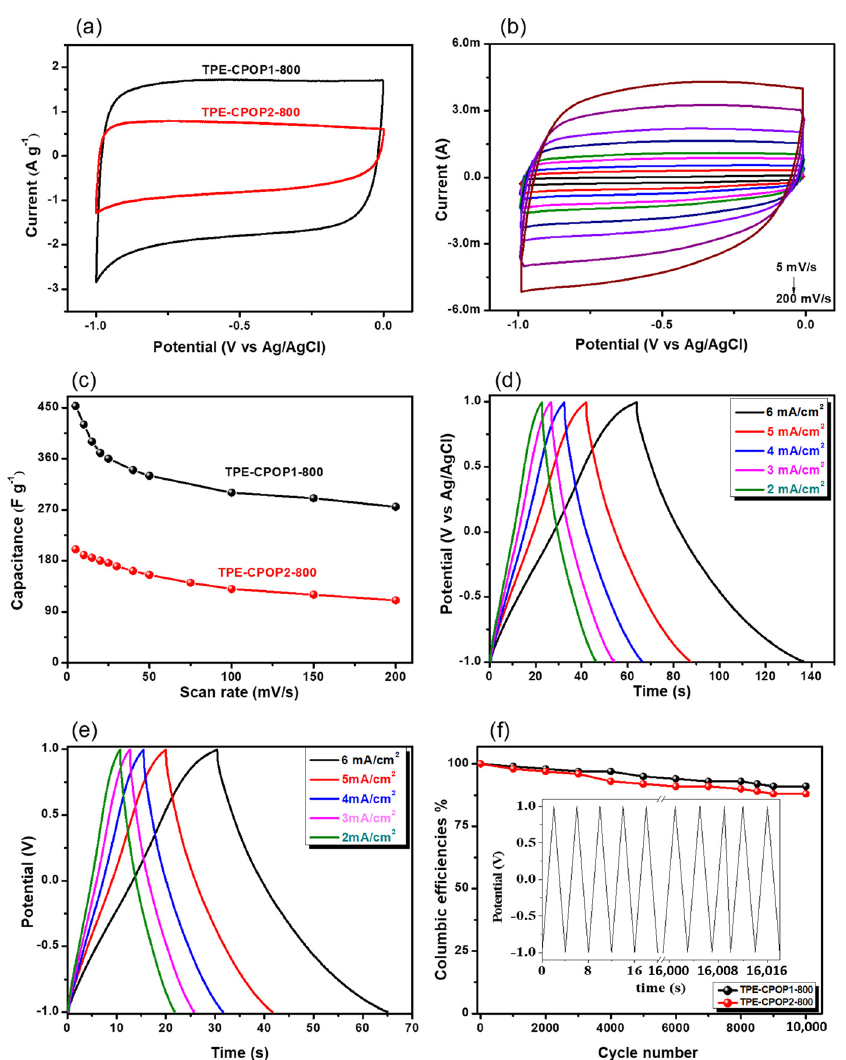
Figure 11. ( a ) Comparison of CV performance between TPE-CPOP1-800 and TPE-CPOP2-800 at 50 mV/s. ( b ) CV performance of TPE-CPOP1-800 at various scan rates (5~200 mV s − 1 ). ( c ) Capacitance performance of TPE-CPOP1-800 and TPE-CPOP2-800 at various scan rates. ( d ) Galvanic charge/discharge (GCD) performance of TPE-CPOP1-800. ( e ) GCD performance of TPE-CPOP2-800. ( f ) Columbic efficiencies of TPE-CPOP1-800 and TPE-CPOP2-800 at 20 A g − 1 for 10,000 cycles. The inset figure represents the first and last few cycles of GCD behavior at 20 A g − 1